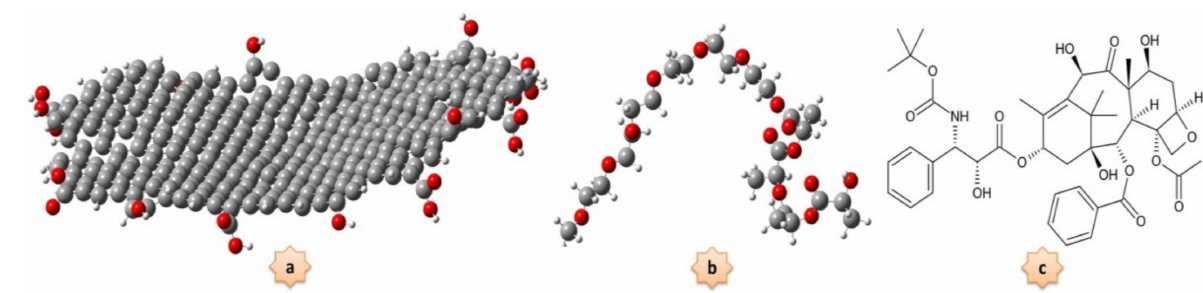
Figure 1. The chemical structure of ( a ) graphene quantum dot oxide; ( b ) PEG-PLA copolymer in the covalent radius with atom colors: white—hydrogen, gray—carbon, red—oxygen; and ( c ) docetaxel drug.